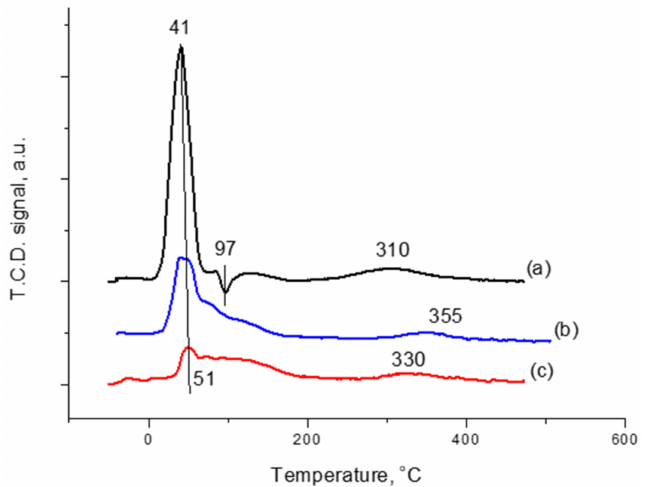
Figure 6. TPR profiles of synthesized samples: ( a ) Pd/ γ -Al 2 O 3 , ( b ) 3Pd1Sn/ γ -Al 2 O 3 and ( c ) 1Pd1Sn/ γ -Al 2 O 3